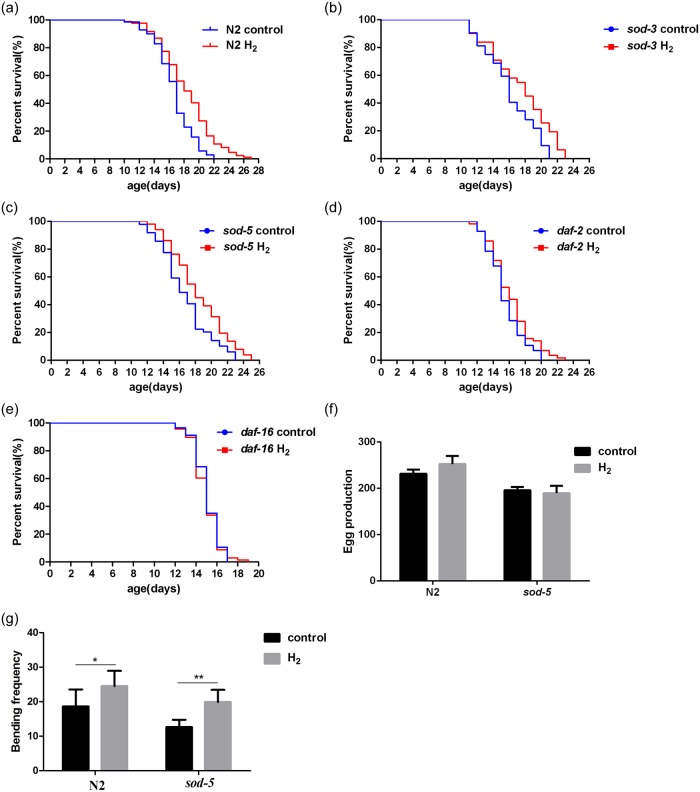
Effects of hydrogen on the lifespan, reproduction and motor behavior of C. elegans.(A-E) Representative Kaplan-Meier survival curves of N2, daf-2, daf-16, sod-3 and sod-5 nematodes after hydrogen treatment (>60 animals per group). (F): Spawning of N2 and sod-5 nematodes with or without hydrogen treatment. (G): N2 and sod-5 nematode head swing frequencies with or without hydrogen treatment. (F) and (G): Data are shown as the mean±SD of three independent experiments. *p<0.05; ** p<0.01.